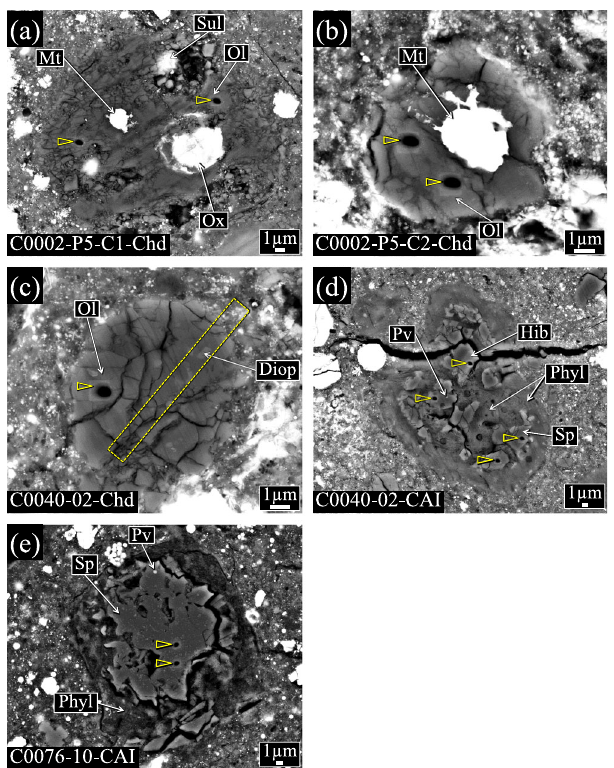
Fig.1|Backscatteredelectron(BSE)imagesofthreechondrule-likeobjectsand two CAIs in the Ryugu samples analyzed for oxygen isotopes. a C0002-P5-C1- Chd, b C0002-P5-C2-Chd, c C0040-02-Chd, d C0040-02-CAI, and e C0076-10-CAI. SIMS analysis spots are shown by the vertex of an open triangle. The rectangle area drownbythedashedlineinpanel( c )correspondstotheregionextractedbytheFIB sectioning.Ol,olivine;Mt,Fe-Nimetal;Sul, Fe-sul fi de;Ox, oxide;Diop,diopside;Sp, spinel; Hib, hibonite; Pv, perovskite; Phyl,